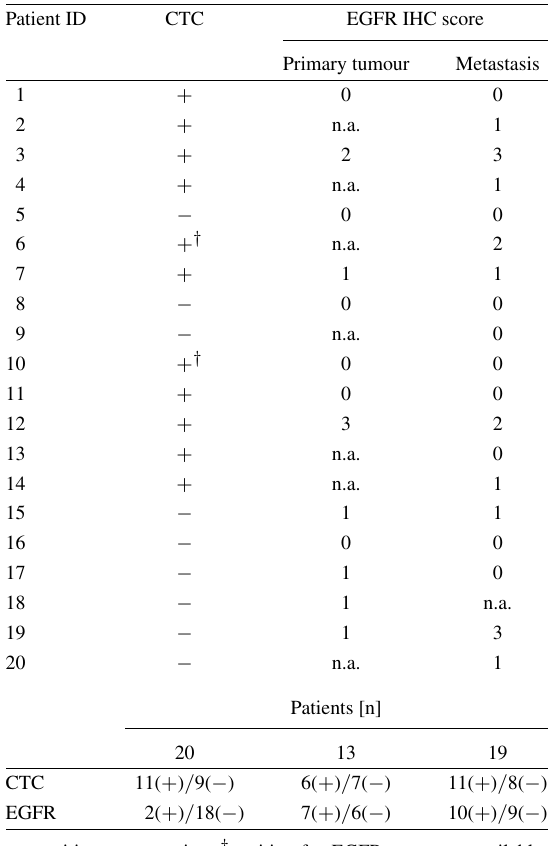
Analysis of CTC and EGFR expression in primary tumour and metastases by